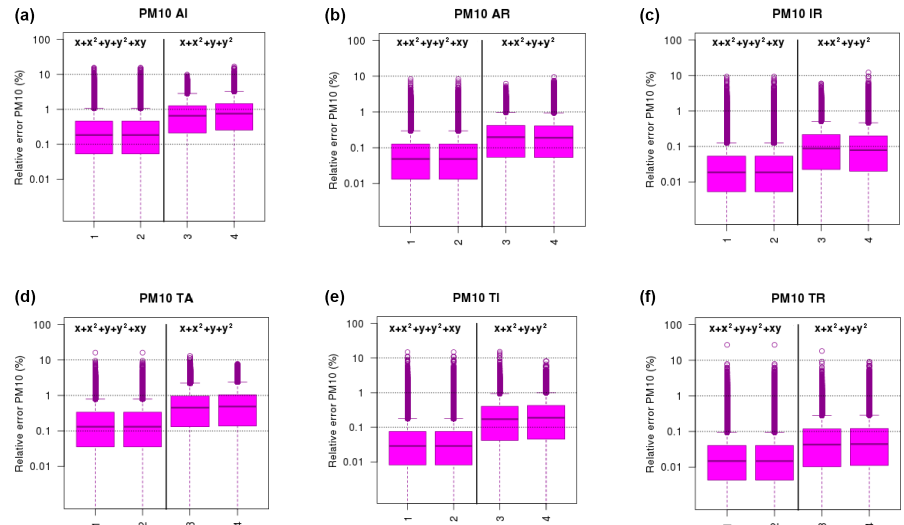
Figure 7. Relative error (%) of the PM 10 bivariate surrogate models ( a–f : AI: AGR and IND, AR: AGR and RH, IR: IND and RH, TA: TRA and AGR, TI: TRA and IND, TR: TRA and RH). For each panel, the box plots of the distribution of errors are given for two models with interactions (a, d) and two models without interactions (c, f) , where indices in the x axis match the row of Table 2. The distributions of relative errors include each grid point in western Europe and each day over three air pollution events (March 2015, December 2016, January 2017). The horizontal dotted lines are for 0.1%, 1% and 10% errors.